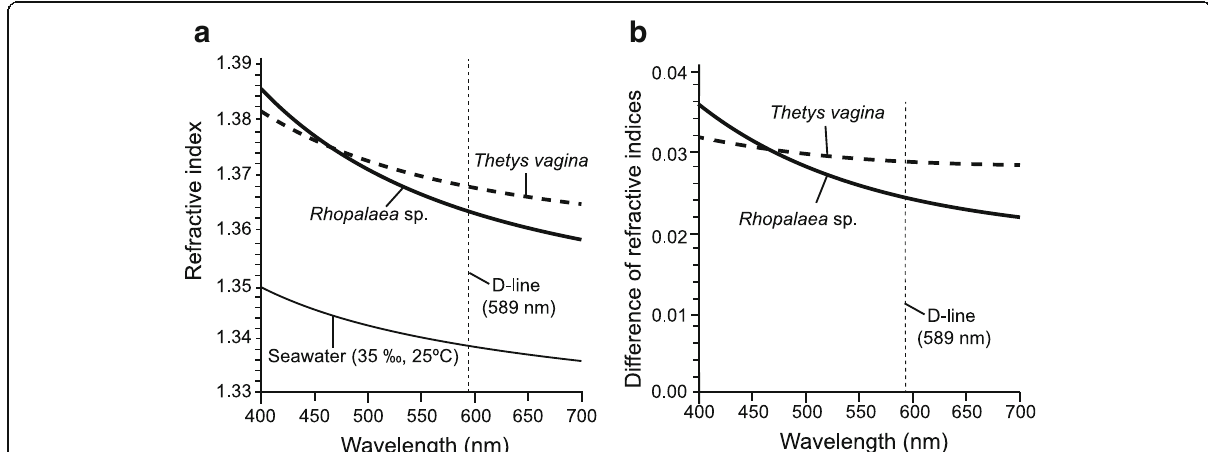
Fig. 3 Refractive indices of tunics and seawater ( a ), and the difference between the two, in the visual light range (400 – 700 nm) ( b ). Refractive indices of the tunic of Thetys vagina (previously frozen specimen) and Rhopalaea sp. (fresh specimen) were calculated from ellipsometric parameters Ψ and Δ (Additional files 2 and 3). The curve for seawater is based on the equation of Quan and Fry [22] that is valid from 400 to 700 nm. The vertical dotted line indicates the wavelength of D-line that was used for the measurement with the Abbe refractometer